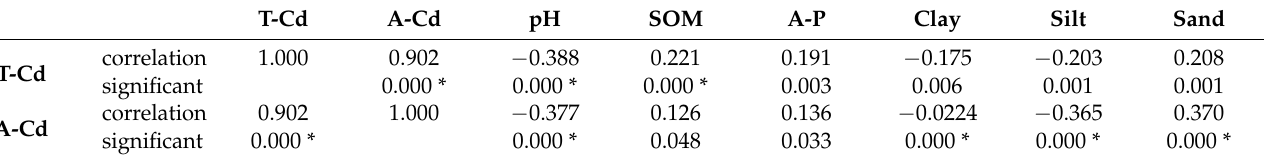
Table 3. General correlation between soil properties and the contents of total and available Cd in